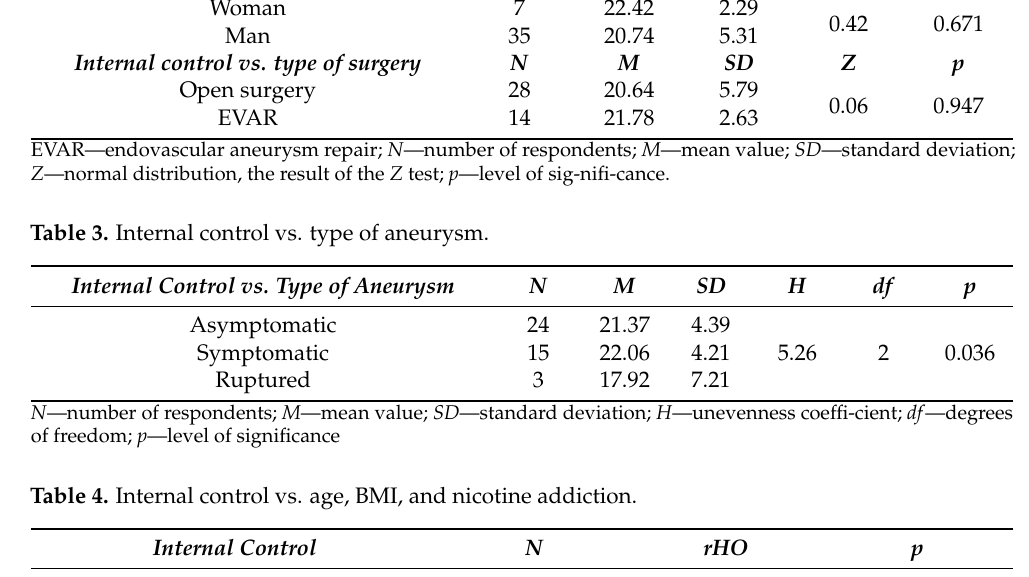
Table 2. Internal control vs. gender and type of surgery. Internal Control vs. Gender